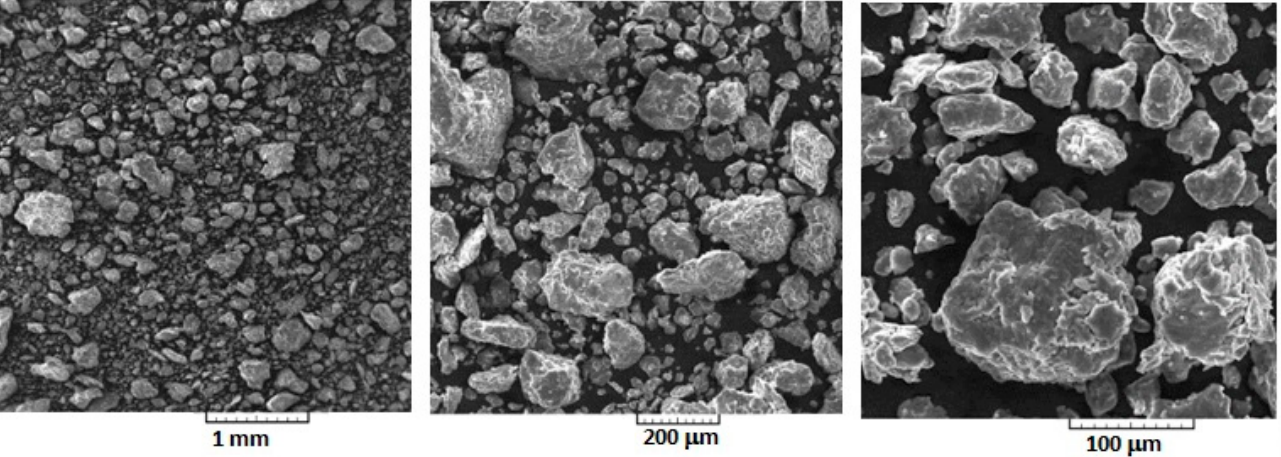
Figure 6. The Mg ‐ 10Zn ‐ 0.8Ca ‐ 0.5Zr (wt.%) alloy ‐ powder processed by mechanical alloying with [200 rpm/24 h/10:1] + [300 rpm/2 h/10:1].